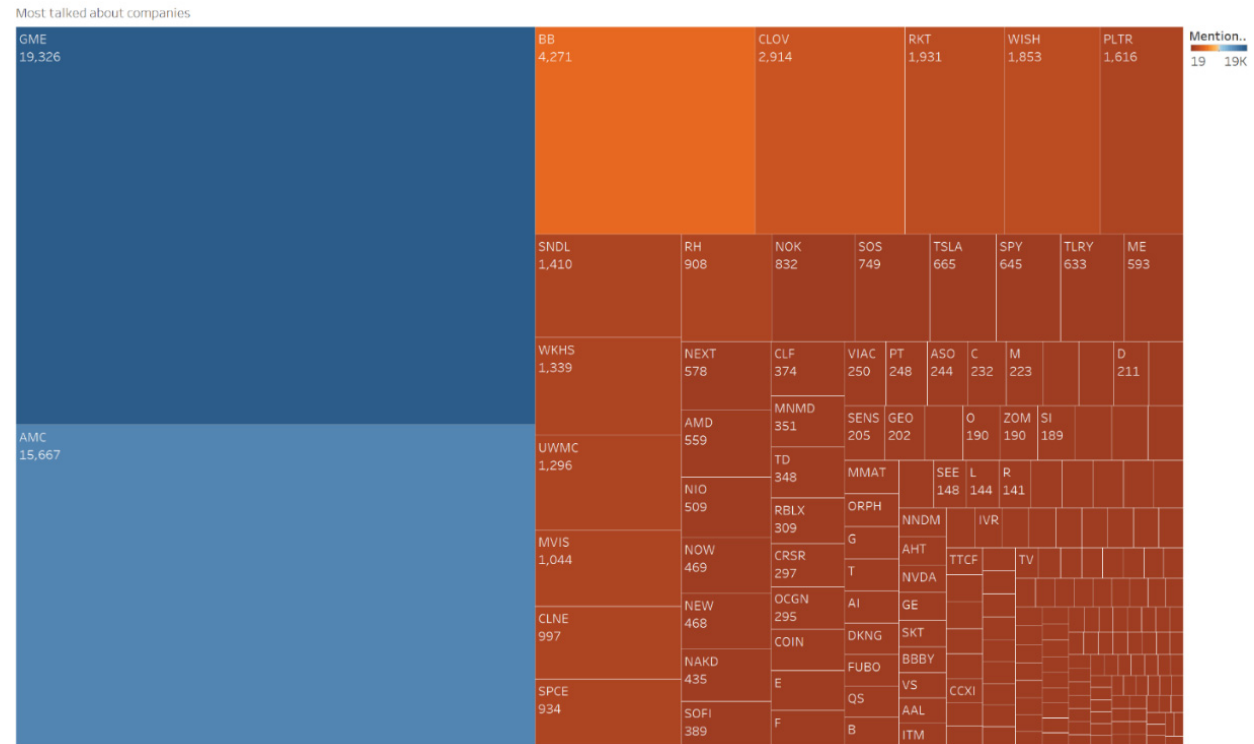
Figure 3. Tree map of the most mentioned stocks.